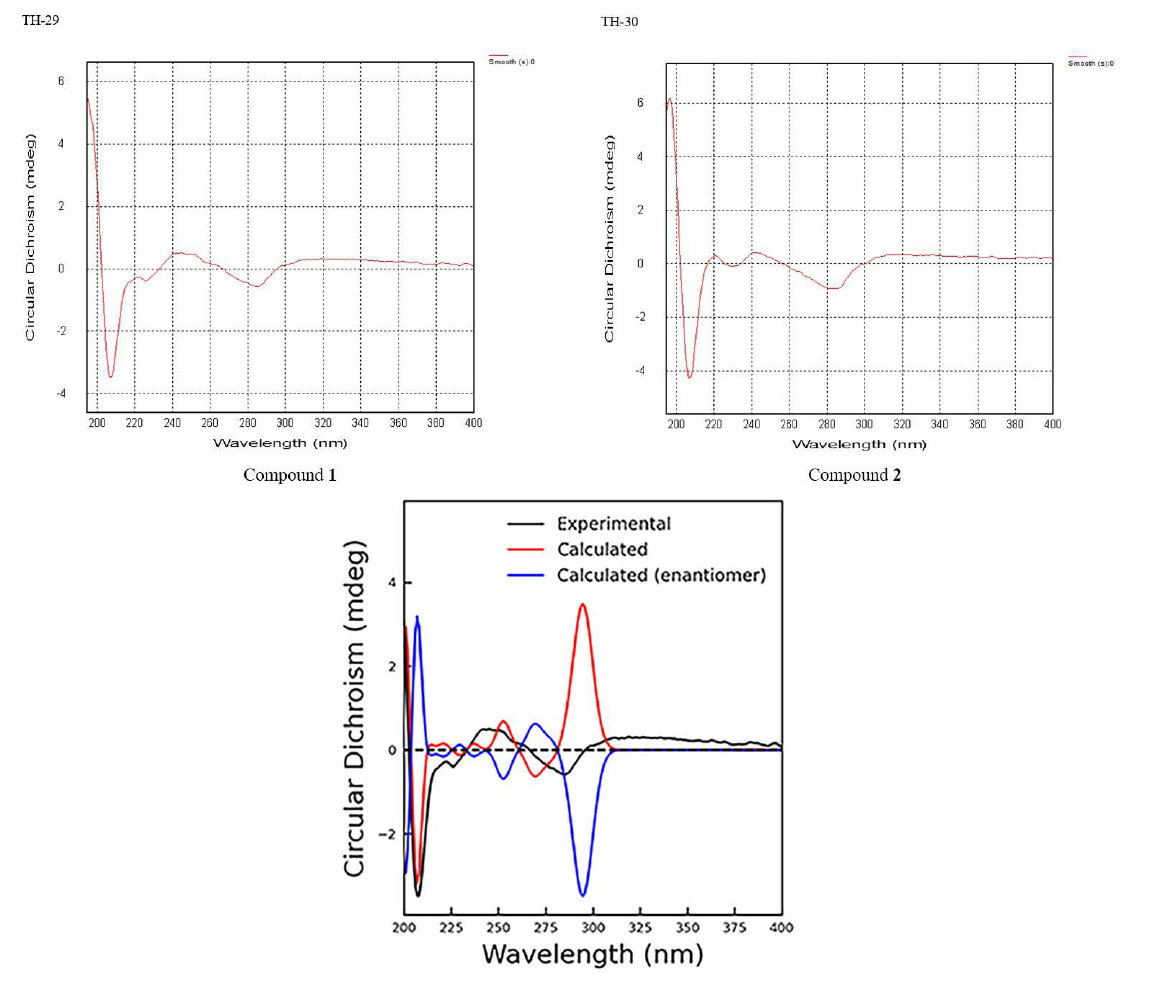
Figure 3. The CD and ECD spectra of compounds 1 – 2